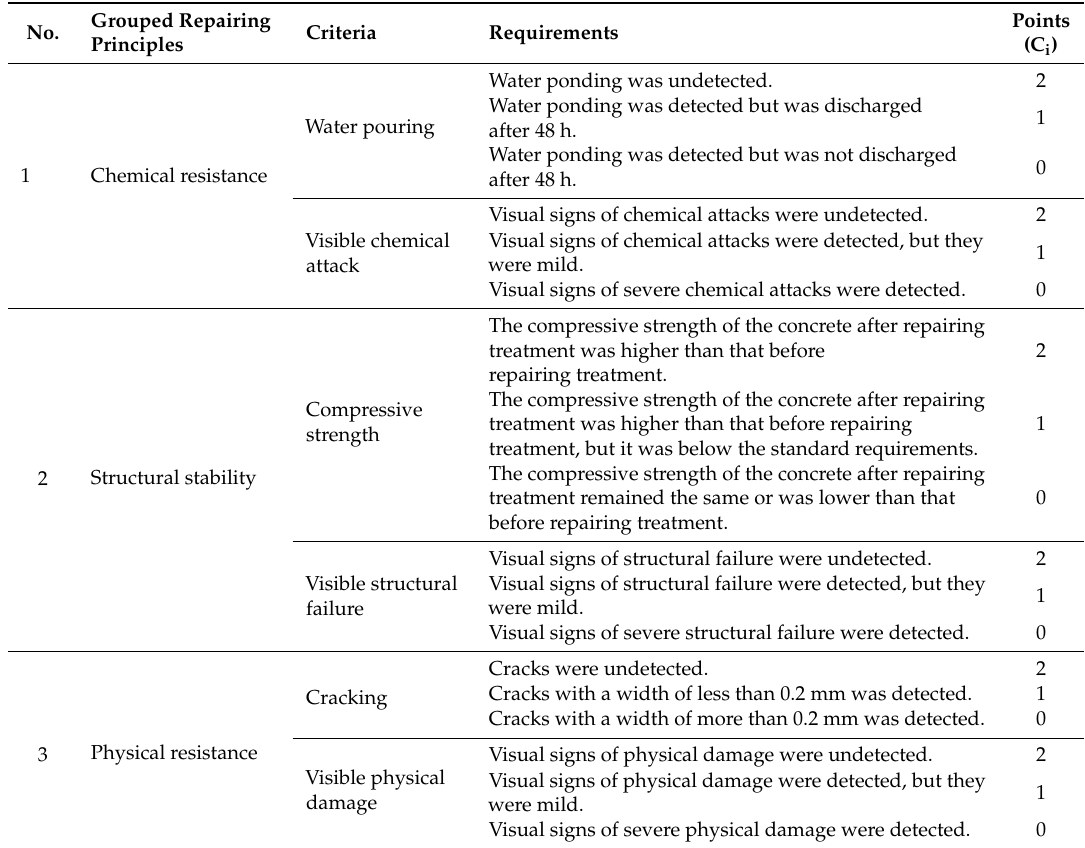
Table 2. Point-scheme for grouped repairing